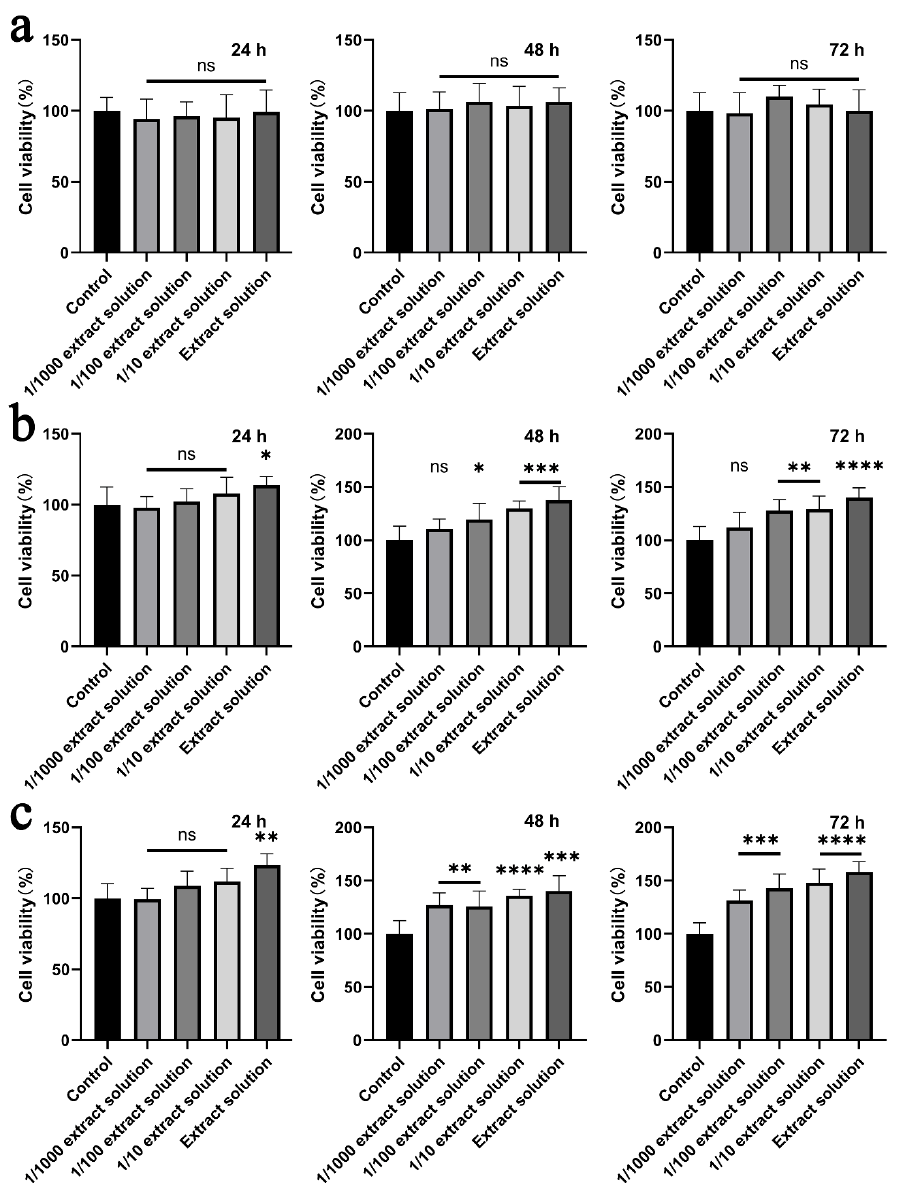
Figure 9. Cytotoxicity profile of the solution extracted from the ( a ) PEO/PVA, ( b ) HHK/PEO/PVA and ( c ) AgNP-HHK/PEO/PVA nanofibrous mats by the NIH3T3 cells. *, p < 0.05; **, p < 0.01; ***, p < 0.001; ****, p < 0.0001. ns, p > 0.05, which meant that there were no significant differences compared to the control; n = 6.